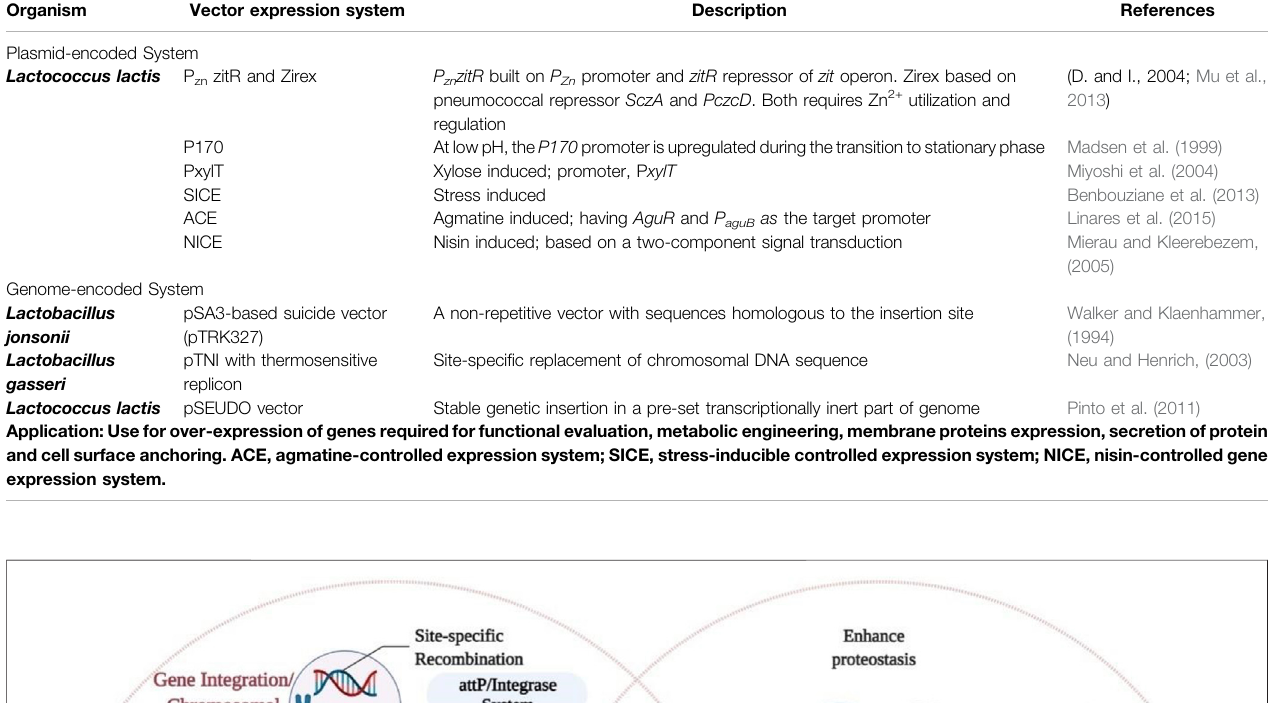
TABLE 1 | Plasmid and genome-based protein expression system in LAB. Organism